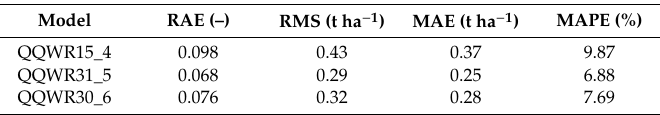
Table 4. Measures prediction of analyzed neural models.